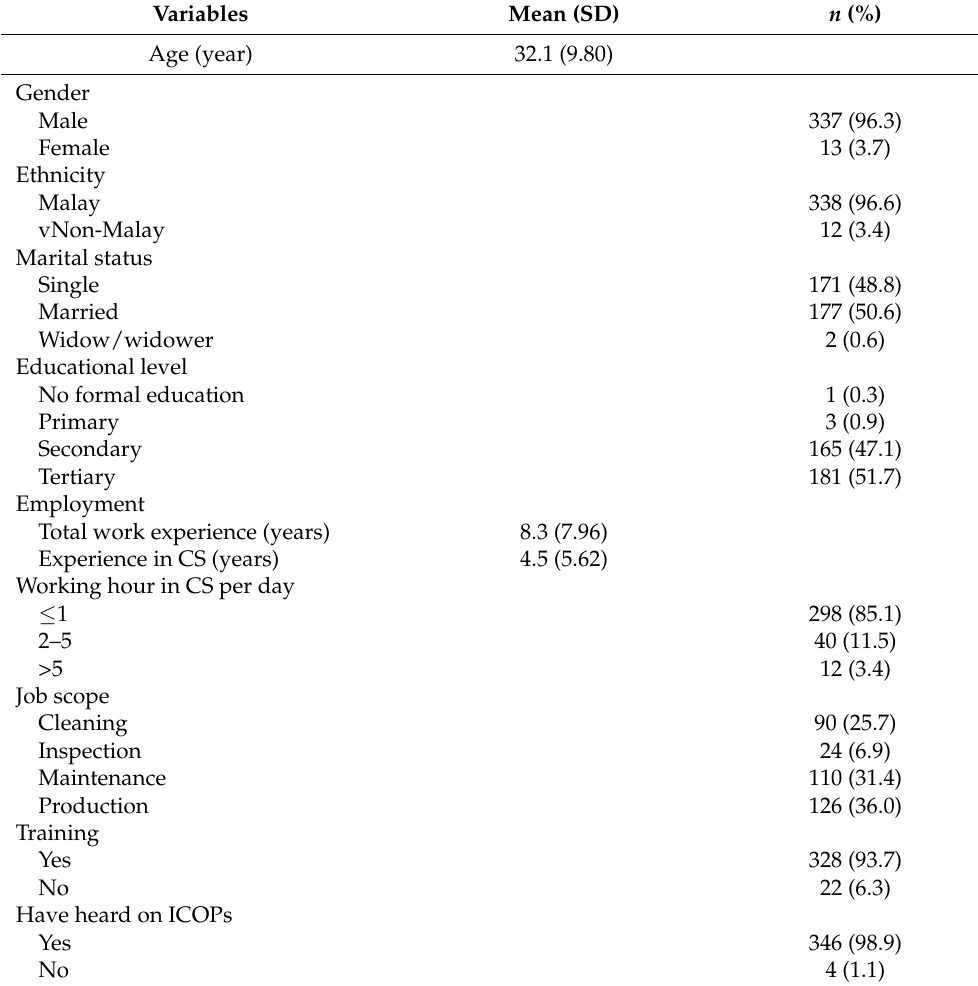
Table 2. Socio-demographic characteristics of confined spaces workers ( n =